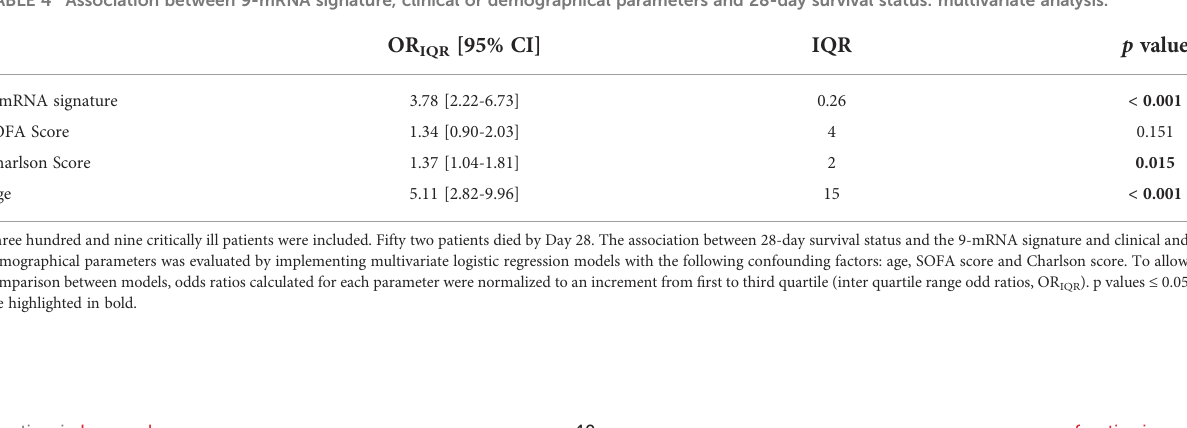
TABLE 4 Association between 9-mRNA signature, clinical or demographical parameters and 28-day survival status: multivariate